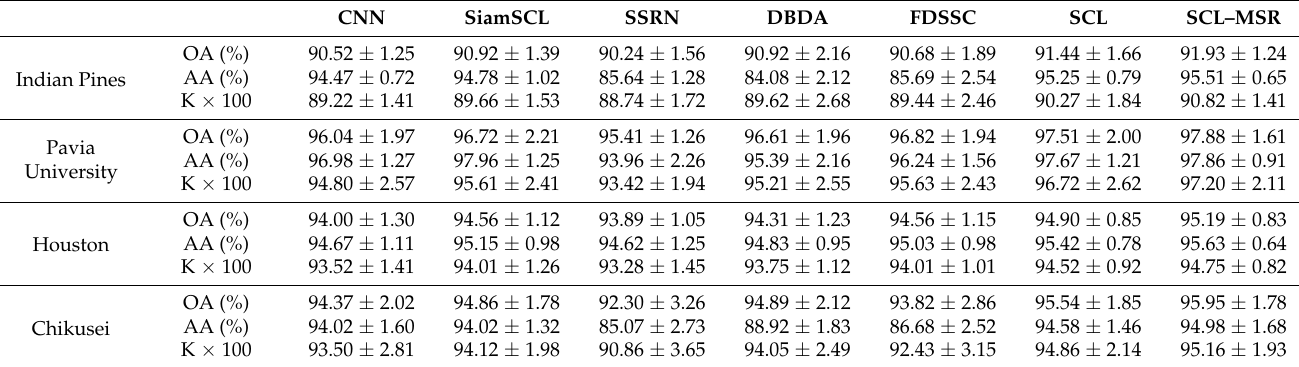
(ii) Classification when spatial resolution is poor. To obtain datasets whose spatial resolutions are poor, we downsample the original image (i.e., remove all odd rows and columns) and then resize them to the original sizes using bilinear interpolation. The obtained resolution of the hyperspectral images will be half of the original. Figure 25 shows the false color maps of the different resolutions for the Indian Pines and the Pavia University datasets.